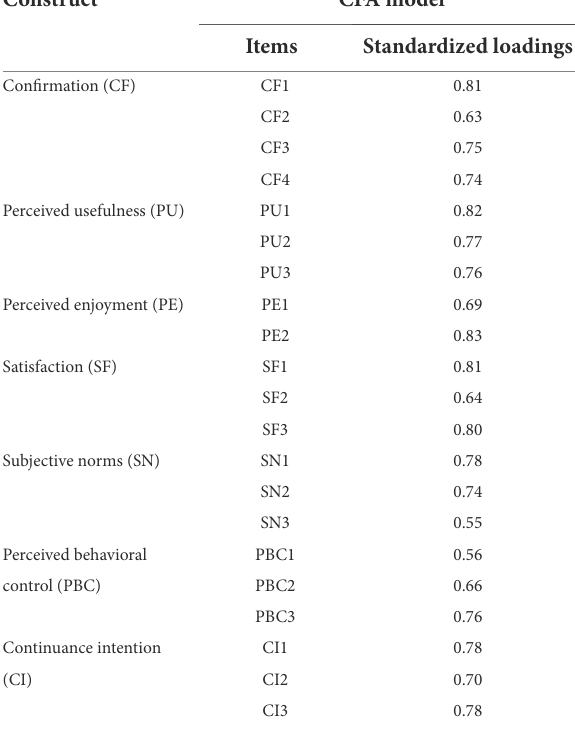
TABLE 3 Standardized loadings of indicators in CFA model ( N =